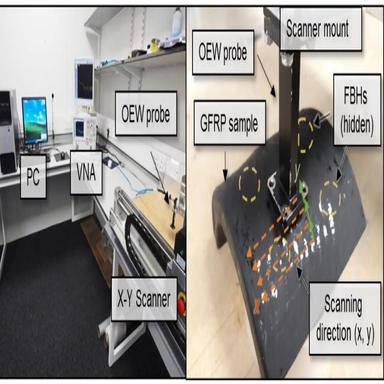
Measurement setup for scanning GFRP pipe sample.